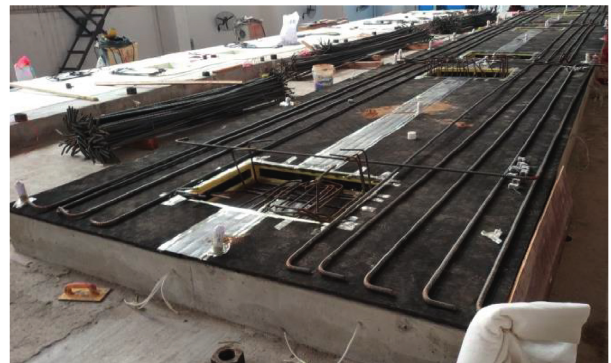
Figure 3: Rubber mat used as the isolation layer in ballastless track.